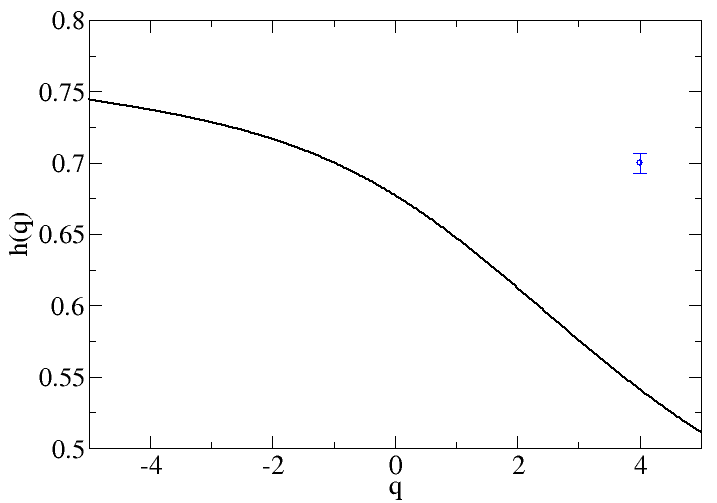
Figure 4. h ( q ) as a function of q at the first time window of the TOPIX time series. The blue symbol with error bar represents a typical fitting error level of